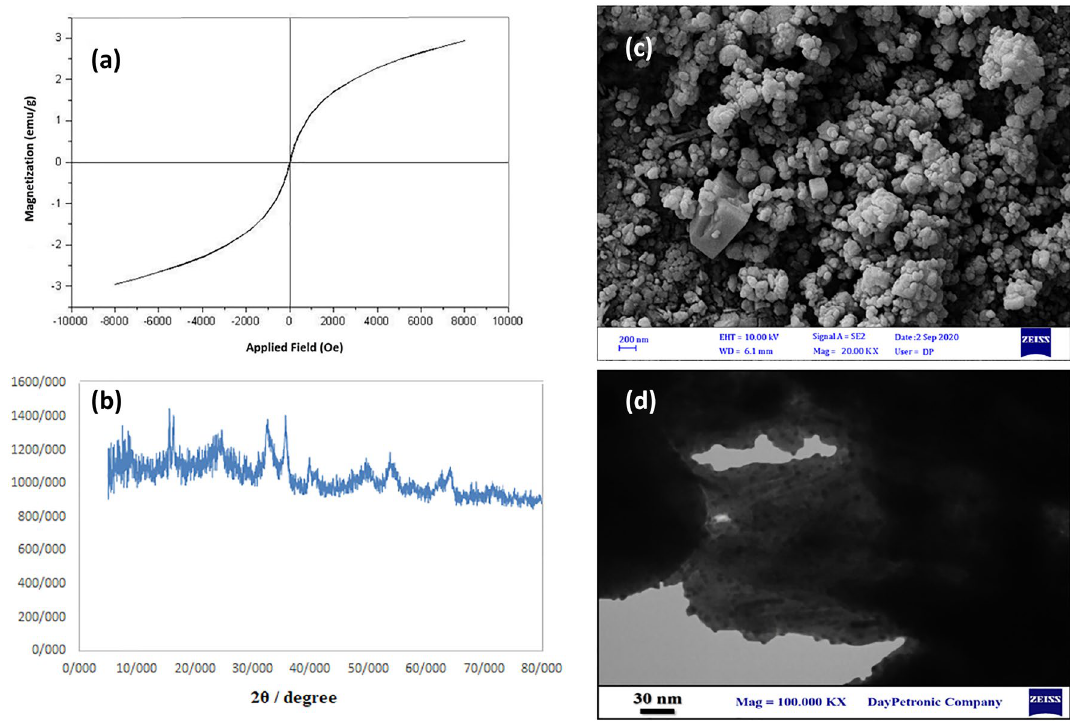
Figure 13. (a) Magnetization curve, ( b ) XRD pattern, ( c ) FESEM and ( d ) TEM image of Fe 3 O 4 @SiO 2 -PMA-Cu in the synthesis of 2-phenyl-2-(4-phenyl-1 H -1,2,3-triazol-1-yl)ethane-1-thiol after five